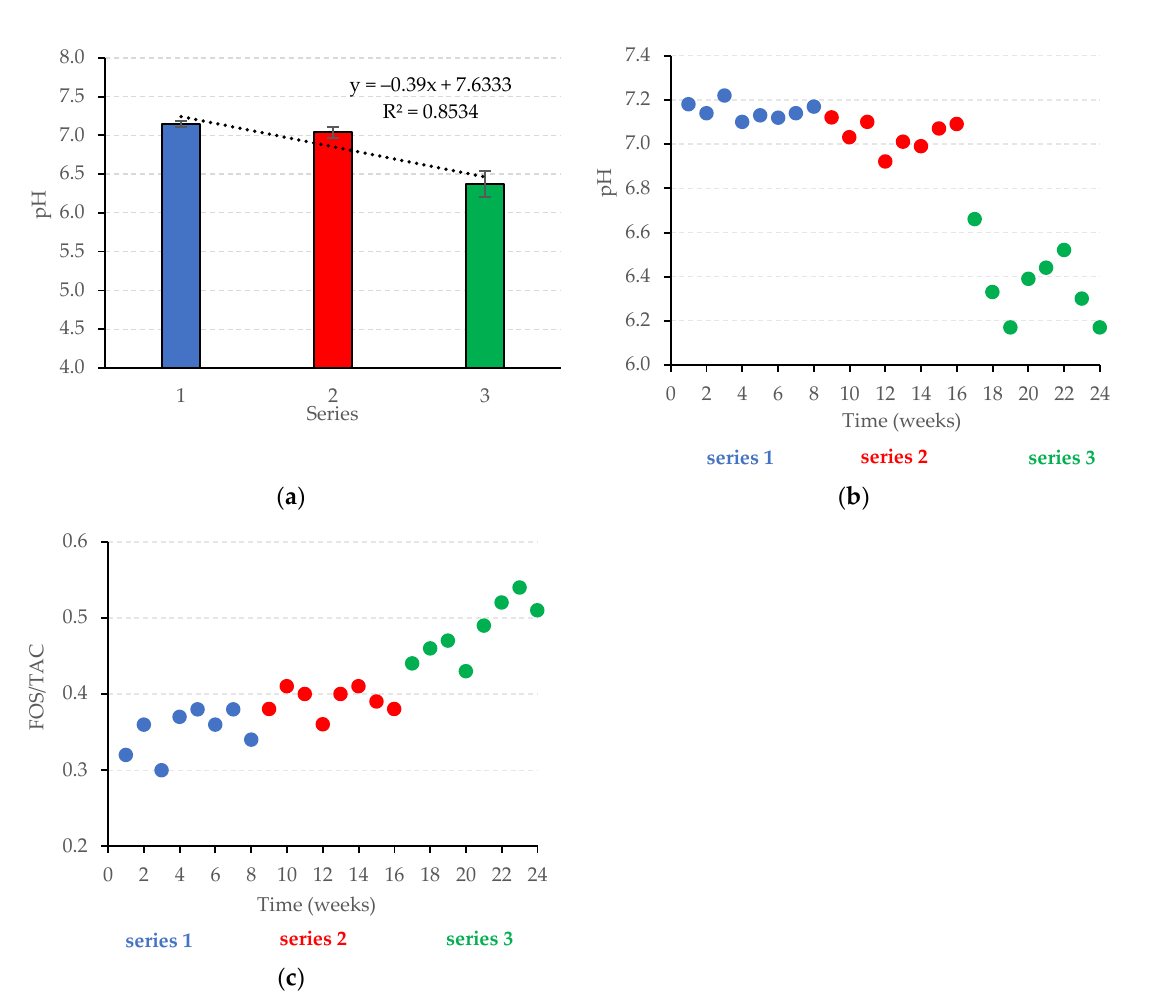
Figure 6. The efficiency of anaerobic confectionery wastewater treatment in stage 2: ( a ) average pH with the standard deviation; ( b ) pH in a chamber during experimental time; ( c ) FOS/TAC ratio in a chamber during experimental time.